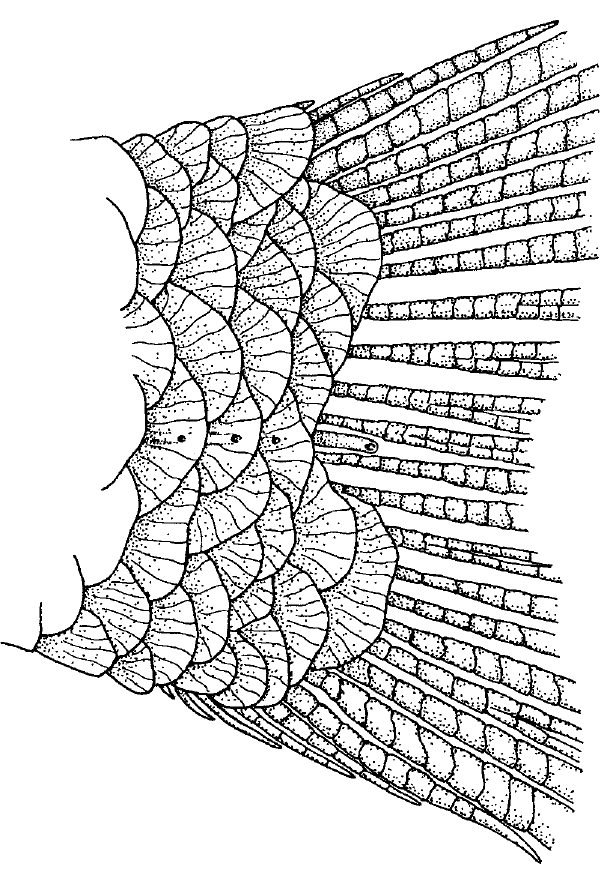
Fig. 12. Bryconamericus iheringii , USNM 285884. Non-in- seminating species. Caudal-fin squamation. Male, SL 53.2 mm, lateral view left side, portraying scales confined to caudal-fin base. Brazil: Rio Grande do Sul, Arroio Garupá, tributary to rio Quaraí, tributary of rio Uruguay. Road: Uruguaiana-Quaraí, locality between Uruguaiana and Quaraí.